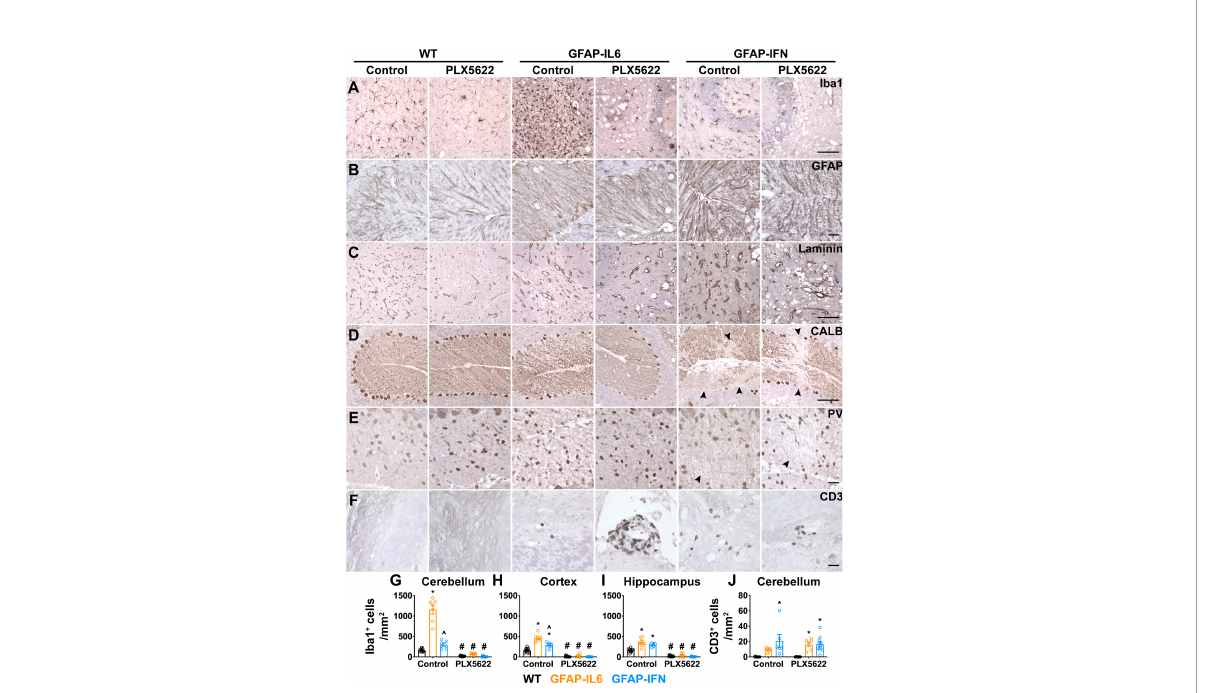
FIGURE 5 PLX5622 treatment of GFAP-IL6 and GFAP-IFN mice does not overtly exaggerate astrocytosis, vasculopathy, neurodegeneration or immune cell in fi ltration in the brain. (A – F) Representative images of the cerebellum of mice treated with control or PLX5622 diet for 12 weeks. (A) Iba1, (B) GFAP, (C) laminin, (D) calbindin (CALB), (E) parvalbumin (PV) and (F) CD3 in the cerebellum. Black arrowheads indicate areas of neuronal cell loss. Scale bars for (A, C, D), 100 m m. Scale bars for (B, E, F), 20 m m. (G – I) Quanti fi cation of the total number of Iba1 + microglia per mm 2 in the (G) cerebellum, (H) cortex and (I) hippocampus. (J) Quanti fi cation of the number of parenchymal, perivascular and meningeal CD3 + T cells per mm 2 in the cerebellum. n=6-12 mice/group. Graphs show individual values per mouse and mean ± SEM. *p<0.05 compared with WT of same condition; ^p<0.05 compared with GFAP-IL6 of same condition; # p<0.05 compared with untreated control of same genotype using two-way ANOVA with Tukey ’ s